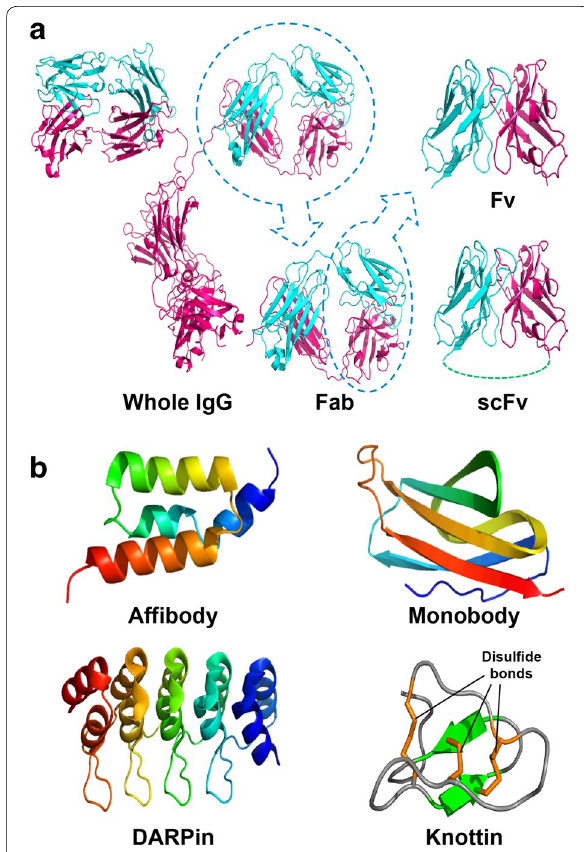
Fig. 2 Targeting molecules. a IgG and its small fragments, b small molecular-binding